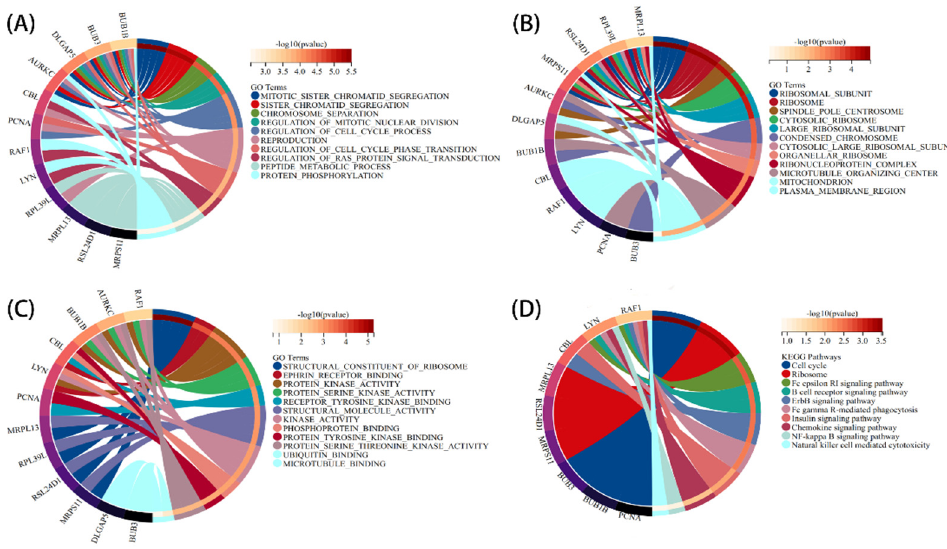
Figure 6. Functional annotation of the hub genes. ( A – C ) The GO enrichment analysis of the hub genes. ( D ) The KEGG pathway enrichment analysis of the hub genes.